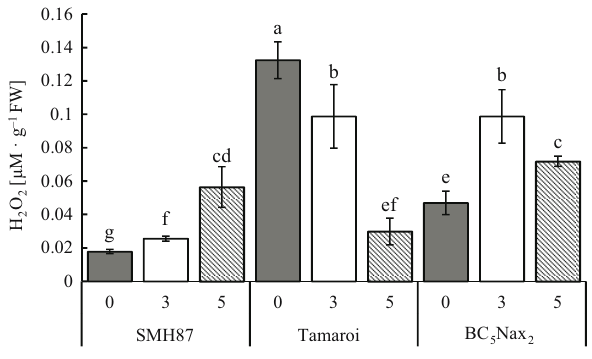
Figure 3: Hydrogen peroxide level in the fl ag leaves of three durum wheat genotypes grown in the soil contaminated with Cd at 0 mg ( control ) , 3 and 5 mg kg − 1 DM. Data are represented as mean ± SE in fi ve replicates, which are signi fi cantly di ff erent at P < 0.05 using Duncan multiple range test.